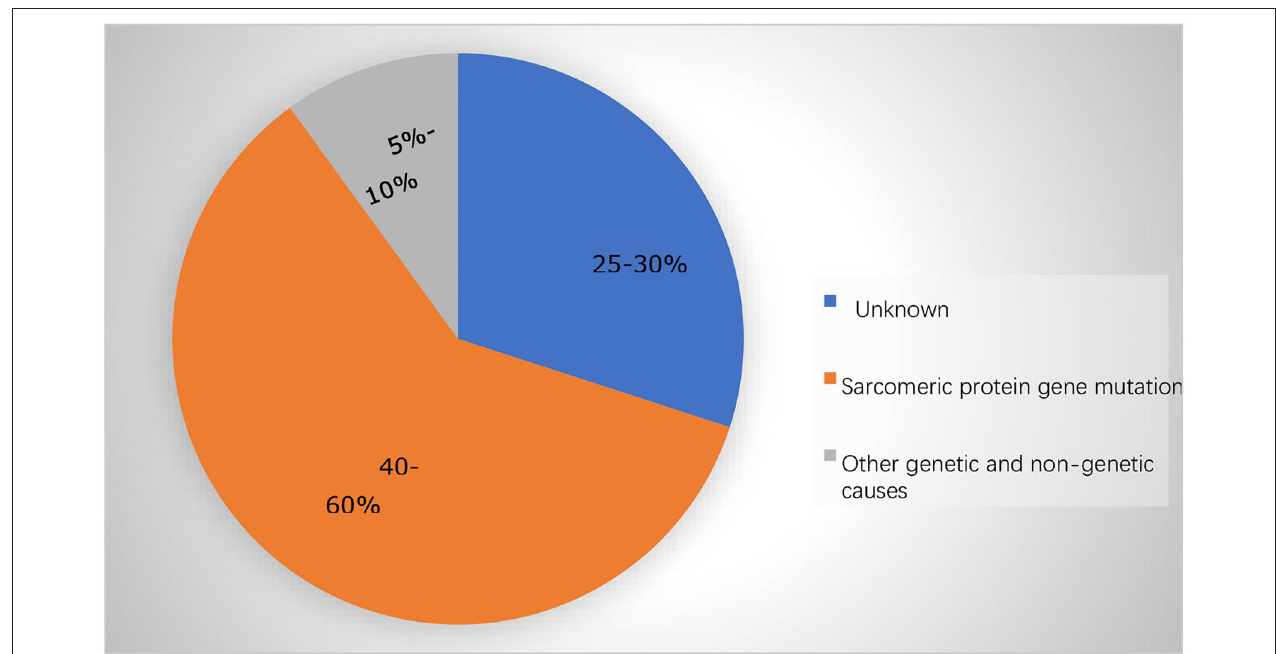
FIGURE 1 | The majority of the cases in adolescents and adults are caused by mutations in the sarcomere protein genes.